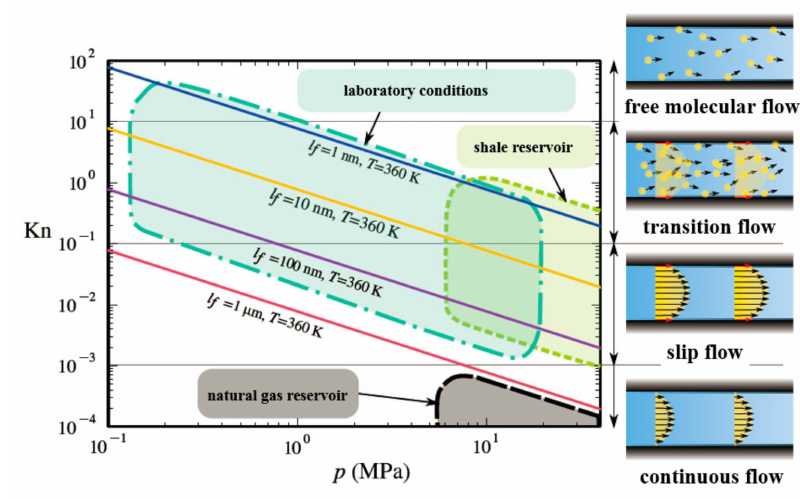
Figure 9. Rarefied gas flow type under di ff erent conditions. This can be divided into free molecular flow ( K n > 10), transition flow (0.1 < K n < 10), slip flow (10 − 3 < K n < 0.1), and continuous flow ( K n < 10 − 3